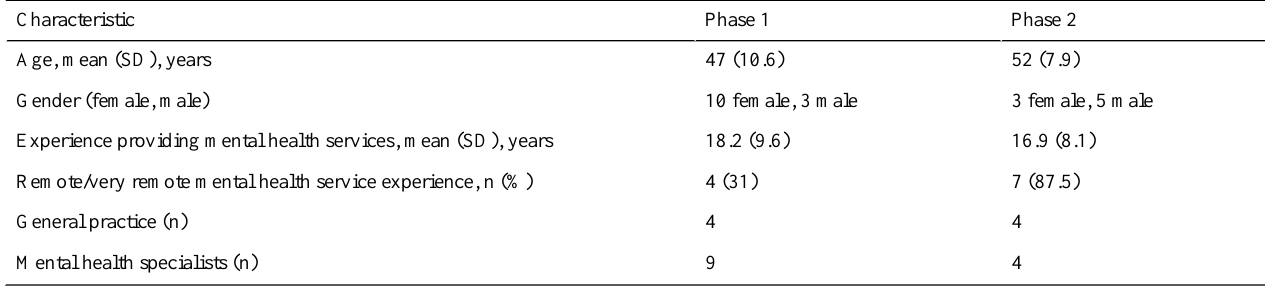
Table 1. Summary of participant